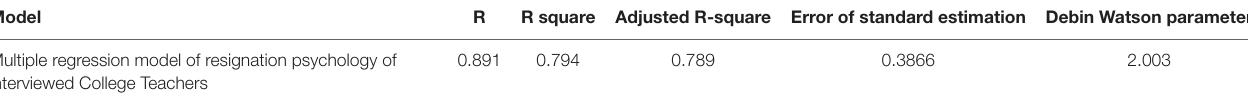
TABLE 1 | Multiple linear regression model and measurement indicators of resignation psychology of interviewed college teachers. Model R R square Adjusted R-square Error of standard estimation Debin Watson parameter Multiple regression model of resignation psychology of interviewed College Teachers